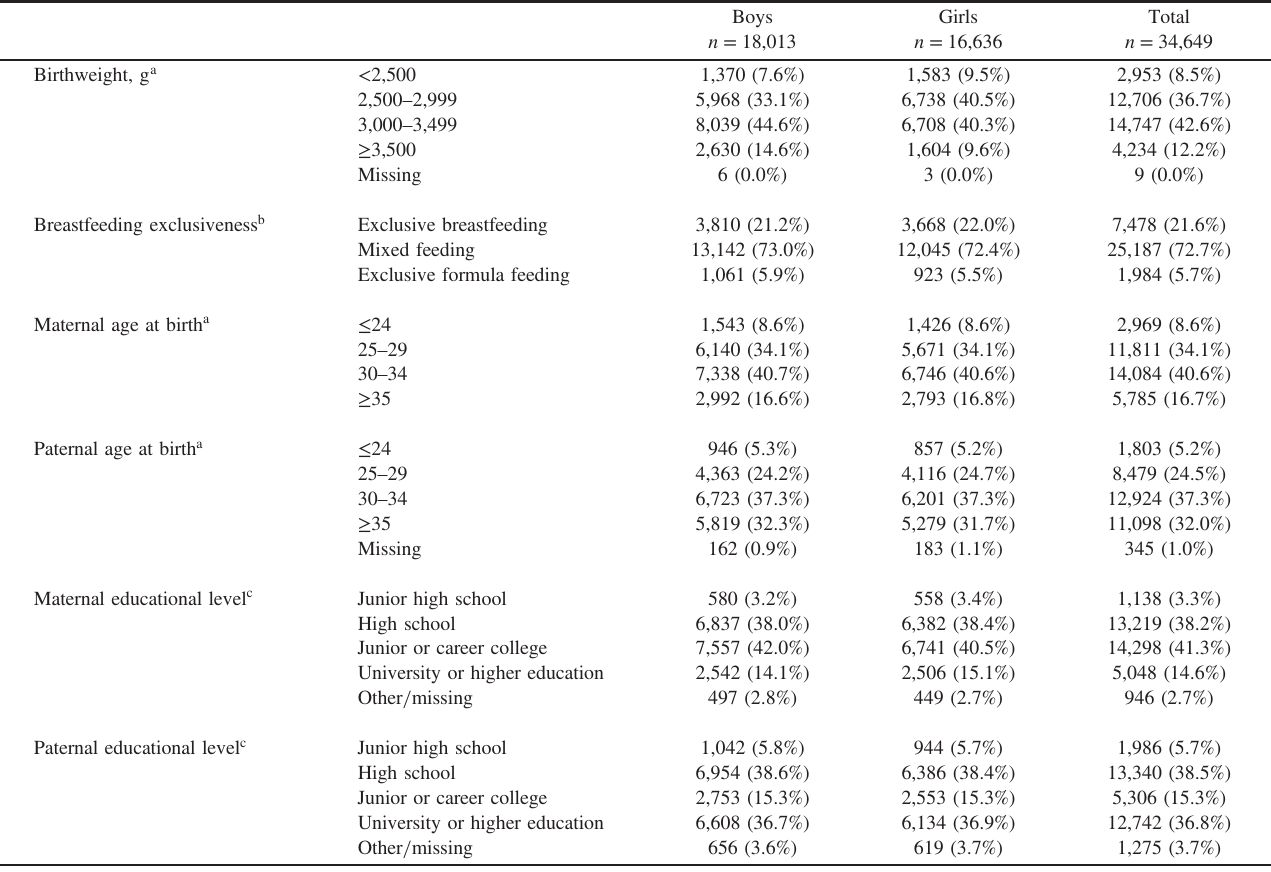
Table 1. Time-invariant characteristics of study subjects at 2.5 years old